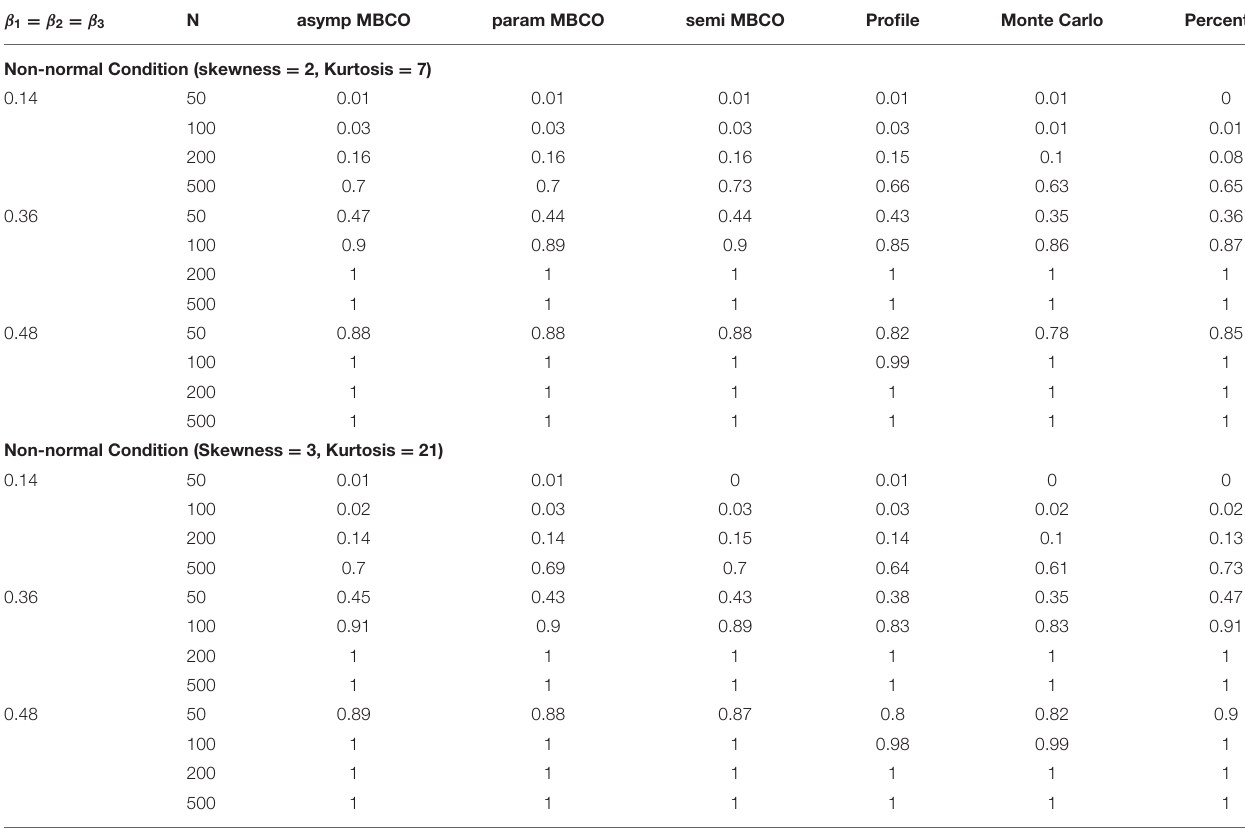
TABLE 2 | Empirical power for six methods of testing indirect effect for non-normal data conditions. β 1 = β 2 = β 3 N asymp MBCO param MBCO semi MBCO Profile Monte Carlo Percentile Non-normal Condition (skewness = 2, Kurtosis = 7) 0.14 50